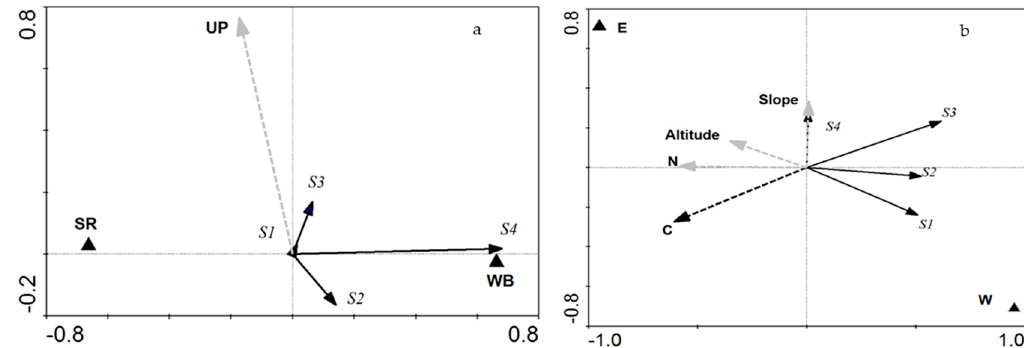
Figure 2. ( a ) Biplot from the pRDA1showing the position of the following: (1) seedling cover each year (solid arrows), (2) significant (dashed black arrows) and not significant (dashed grey arrows) foraging variables. Eigenvalues: axis 1 = 0.122, axis 2 = 0.014, axis 3 = 0.255. ( b ) Biplot from the pRDA2 showing the position of the following: (1) seedling cover each year (solid arrows), (2) significant (dashed black arrows) and not significant (dashed grey arrows) topography variables. Eigenvalues: axis 1 = 0.227, axis 2 = 0.049, axis 3 = 0.017. Dummy variables are represented by solid black (significant) and grey (not significant) triangles. E: east, W: west, SR: small ruminant, WB: wild boar, FUP: forage utilization percentage, Slope: slope inclination (%), N: N soil content (%), C: C soil content (%).